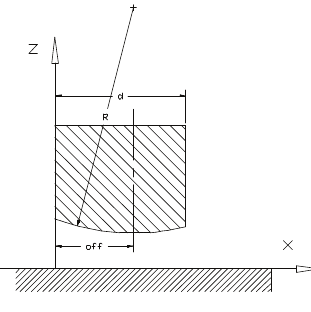
Fig. 4. Piston ring geometry: d – ring axial height, R - radius of the ring surface, O ff – offset of the ring sliding